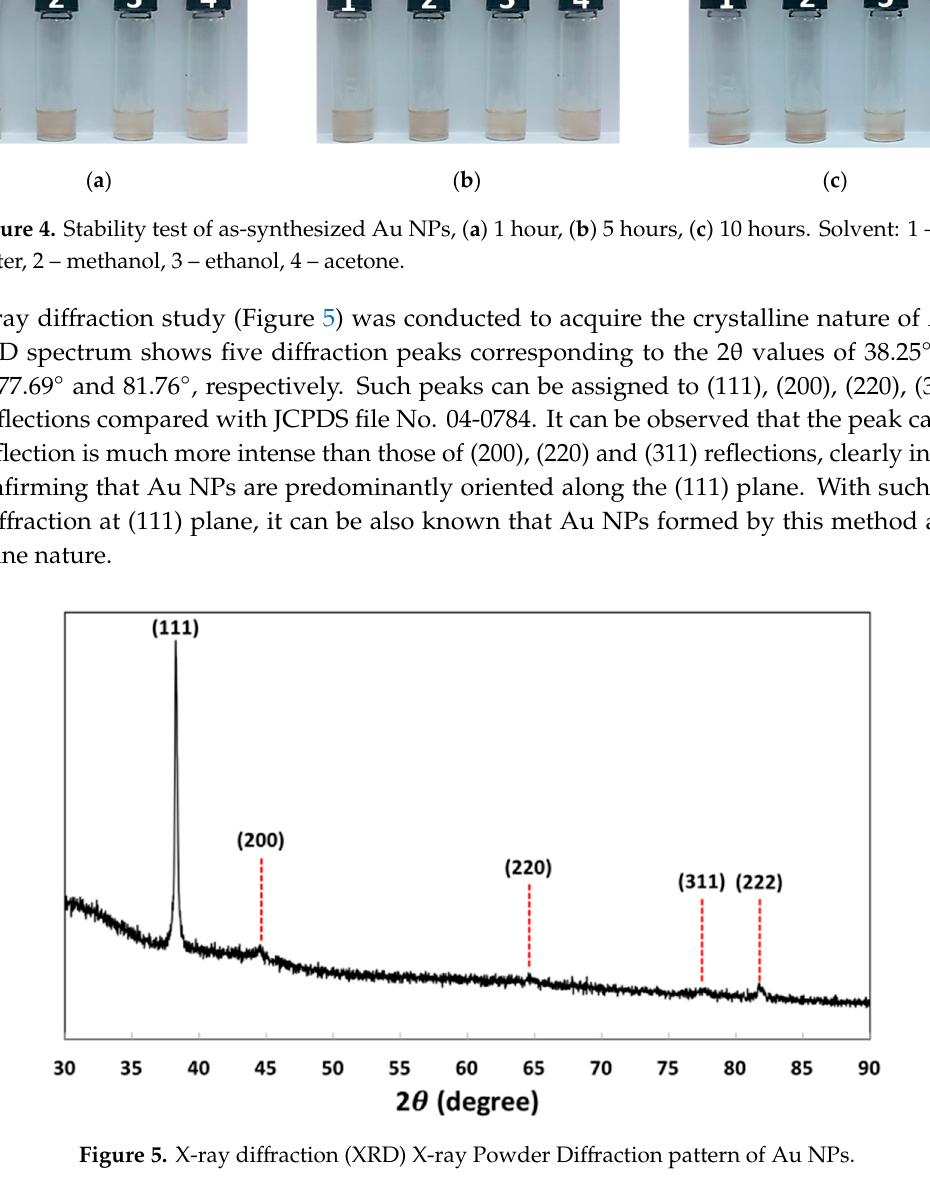
Figure 5. X-ray diffraction (XRD) X-ray Powder Diffraction pattern of Au NPs.